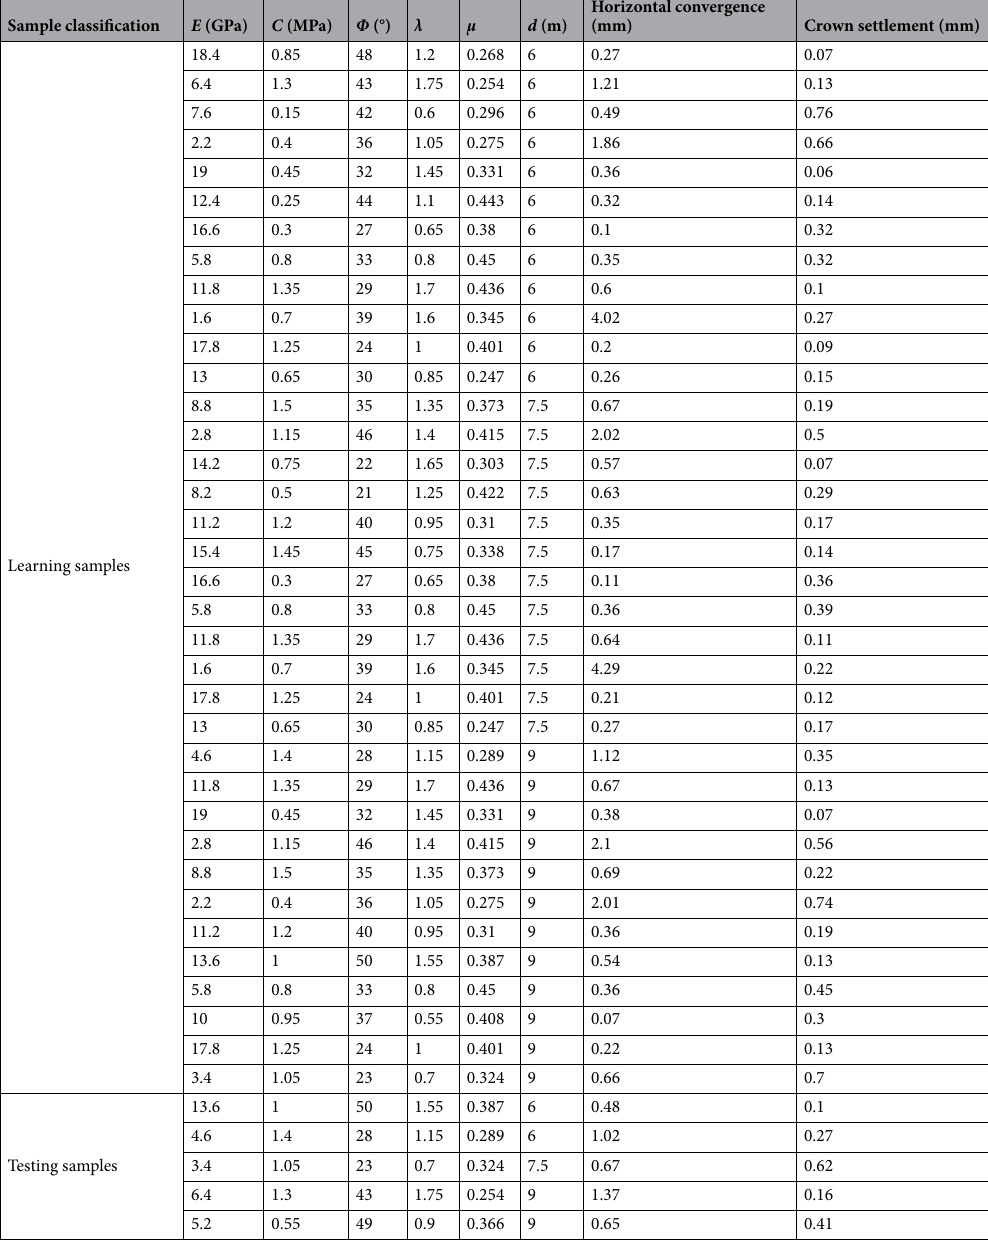
Table 3. Training sample set. Here and elsewhere, the symbol “ d ” represents the distance from the tunnel face to monitoring section LK59 +